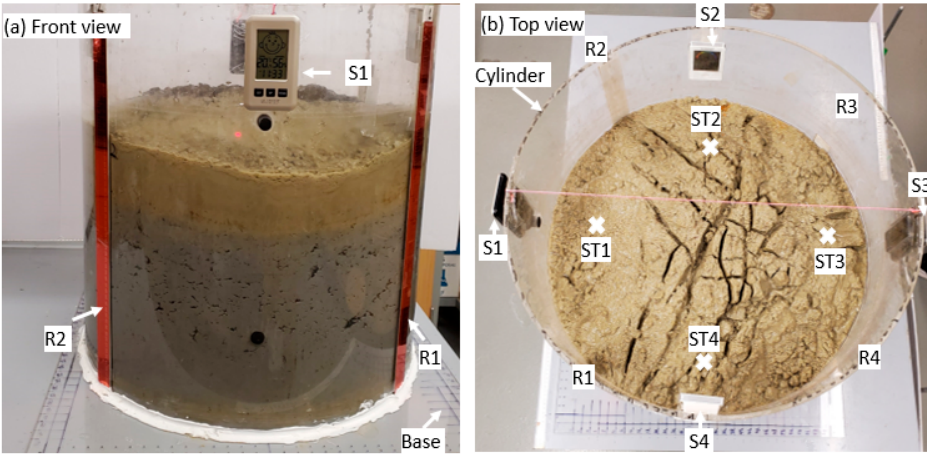
Figure 2. Photographs of instrumented large cell containing the expansive clay: ( a ) front view; ( b ) top view.